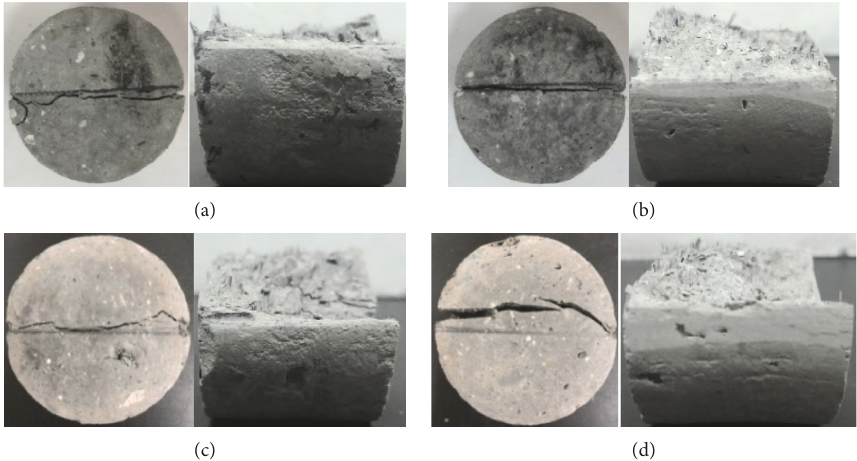
Figure 13: Failure modes under splitting tensile tests: (a) initial state; (b) 30 day; (c) 90 day; (d) 150